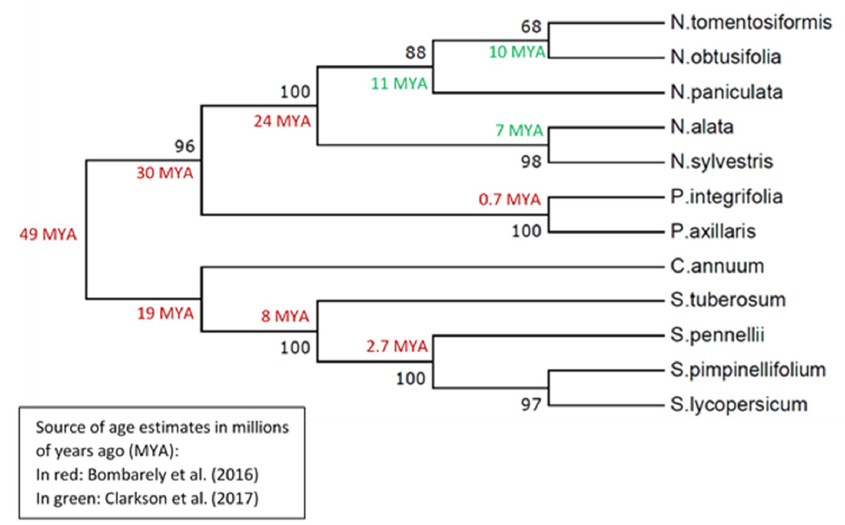
Figure 9. Phylogenetic reconstruction of HD-AGP proteins using the UPGMA statistical method in the MEGA7 package with 1000 bootstrap replications. The genetic distances were computed using the Tamura-Nei model and are in the units of the number of base substitutions per site. The divergence time estimates, where available, are from two published sources: From Clarkson et al. [36] for the Nicotiana species and from Bombarely et al. [27] for some of the remaining species. The age of some of the crown species is difficult to estimate because they are very young lineages.